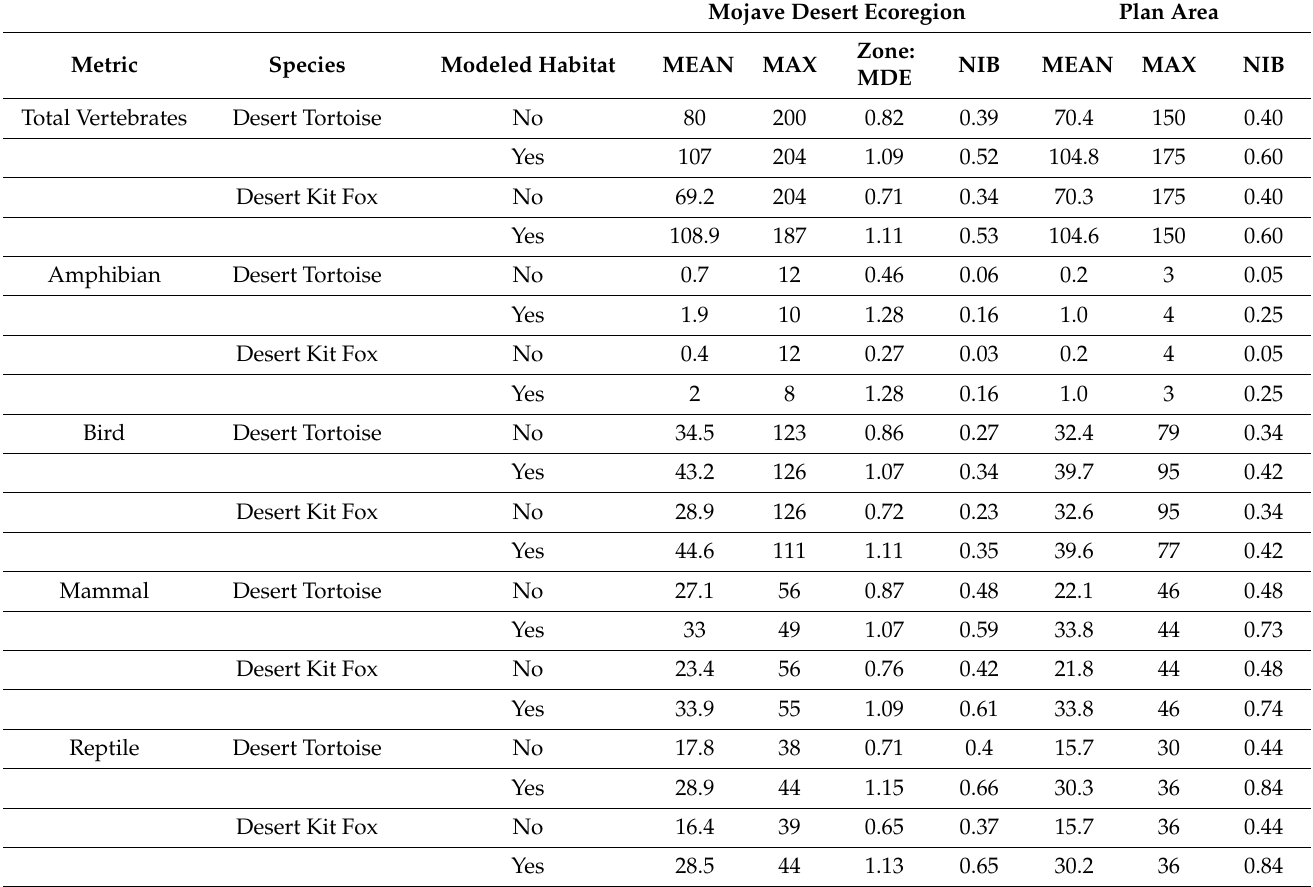
Table 4. Zonal statistics for umbrella species comparison to biodiversity metrics within the Apple Valley Multi-Species Habitat Conservation Plan Area and the Mojave Desert Ecoregion (MDE). Normalized Index of Biodiversity (NIB: mean species richness within the zone divided by the maximum number of species found within the MDE). Zone: MDE (ratio of mean species for zone to the mean species for the